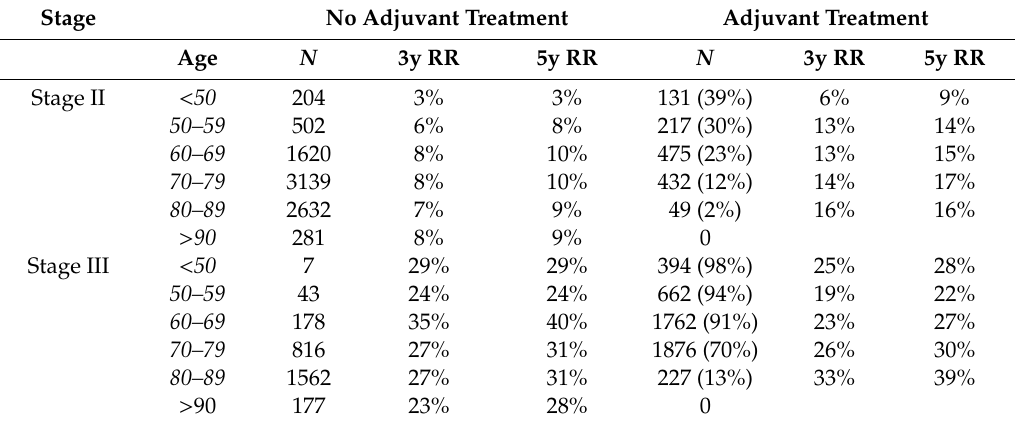
Table 1. Censored recurrence risks (RR) at 3 and 5 years in the entire Swedish colon cancer